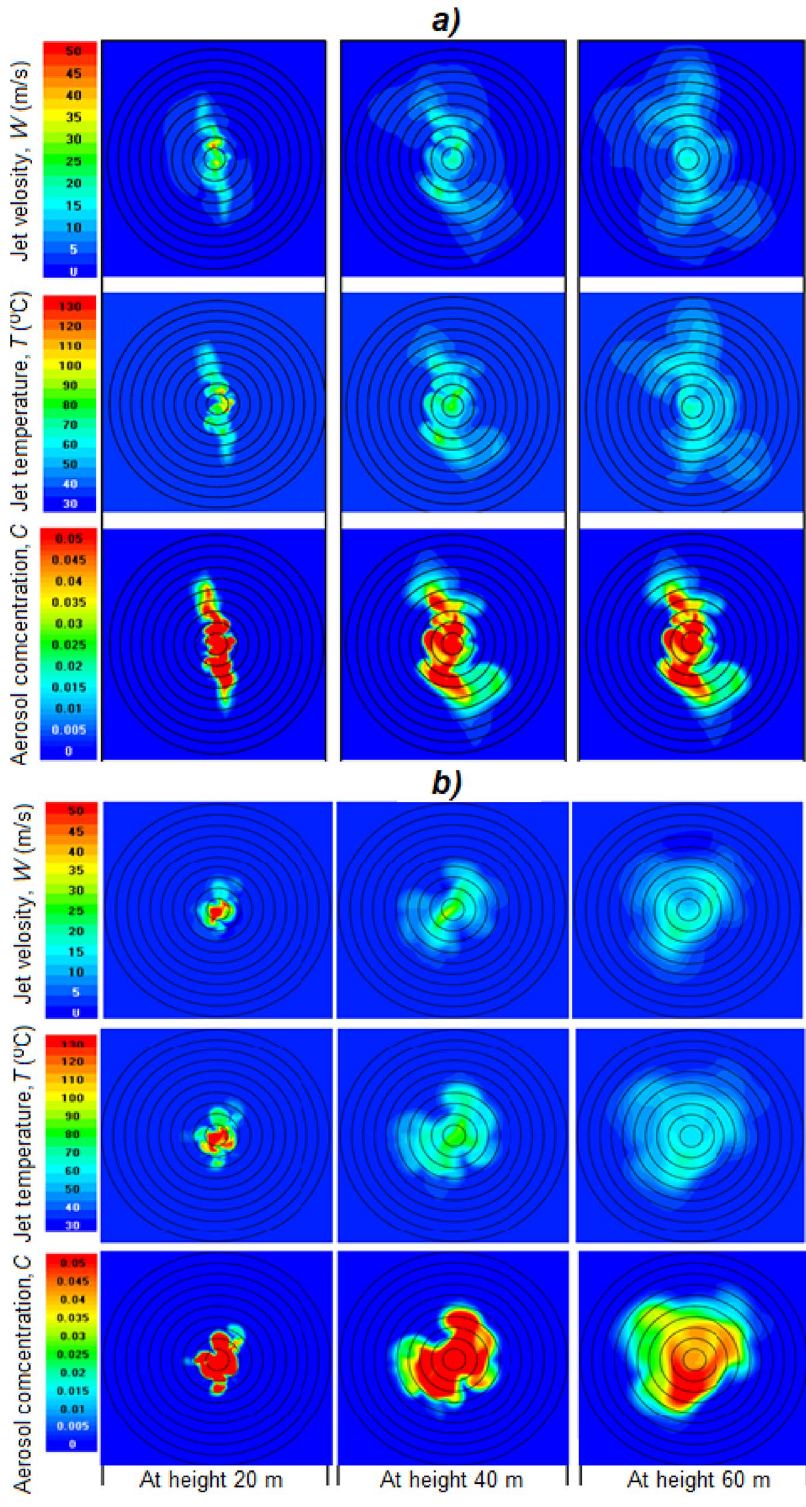
Figure 9. Horizontal sections of W , T and C fields at altitudes of 20, 40, 60 m in windless atmosphere with γ = 6.5 °C/km and f = 45% at 25 s ( a ) and 28 s ( b ) of